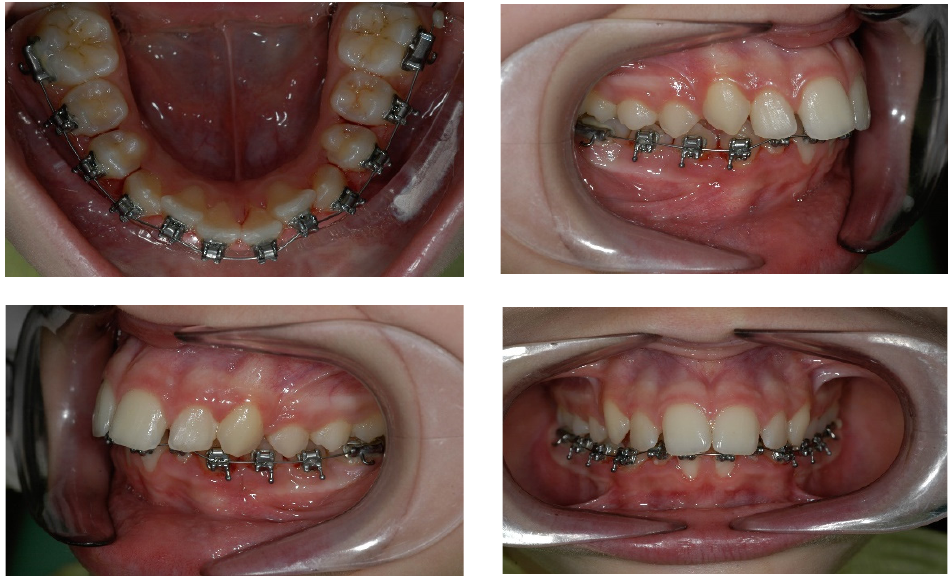
Figure 8. Bonding of the lower arch using the In-Ovation system.